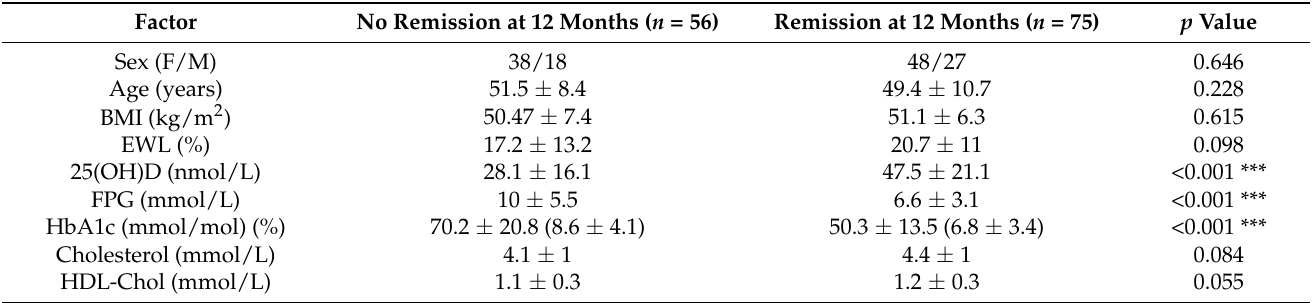
Figure 5. Baseline 25(OH)D Predicts T2DM Remission One-Year Post-Surgery. ( A ) Expected and observed numbers of participants who either increased/did not change their anti-diabetic medication dose or decreased/stopped their medication at 12 months post-surgery, according to their baseline 25(OH)D status. ( B ) Bar chart showing mean baseline circulating 25(OH)D values for patients who increased/did not change their anti-diabetic medication dose ( ↑ dose) ( n = 20), or decreased/stopped their medication ( ↓ dose) ( n = 74) at one-year post-surgery. Data are displayed as mean ± standard error of the mean. Statistical mean differences were determined by 2-tailed independent samples t -test (Mann-Whitney U). ** p < 0.01. ( C ) Bar chart showing mean circulating 25(OH)D values at baseline, 6 months and one-year post-surgery for patients who were in remission ( n = 60) and patients who remained diabetic ( n = 48). Data are displayed as mean ± standard error of the mean. Statistical differences between the groups were analyzed using 2-tailed independent samples t -test. *** p < 0.001. Table 3. Comparison of Pre-Surgery Factors in Participants with and without Diabetes